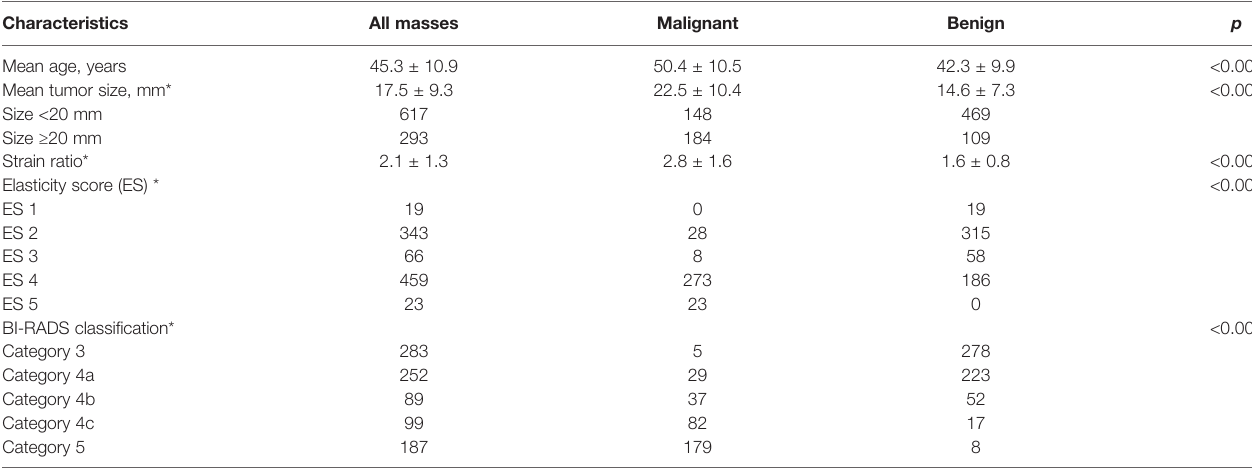
TABLE 2 | The characteristics of patients and breast masses.